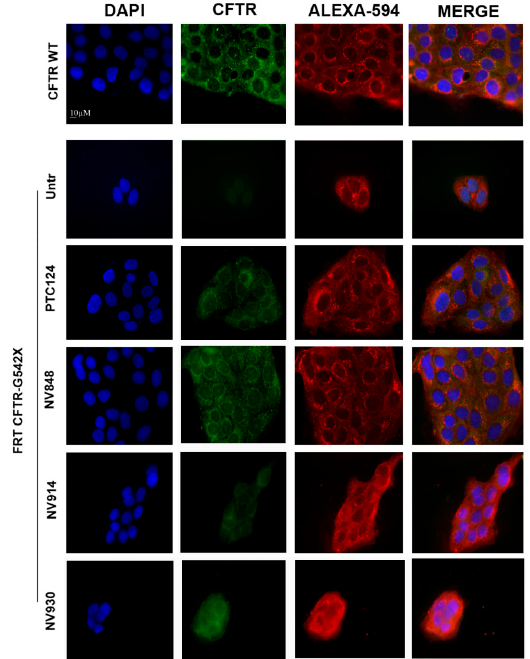
Figure 6. Immunofluorescence analysis of the full-length CFTR protein in wild-type (CFTR-WT) and CFTR G542X Fisher rat thyroid (FRT) cells, untreated (Untr) or treated with 12 µ M PTC124, NV848 , NV930 , or NV914 for 24 h. CFTR protein was revealed by a specific antibody (ab570-green). Nuclei (blue) were DAPI (4 ′ ,6-diamidino-2-phenylindole)-stained and the cellular membrane was stained by wheat germ agglutinin (WGA)-Alexa 594 (red).